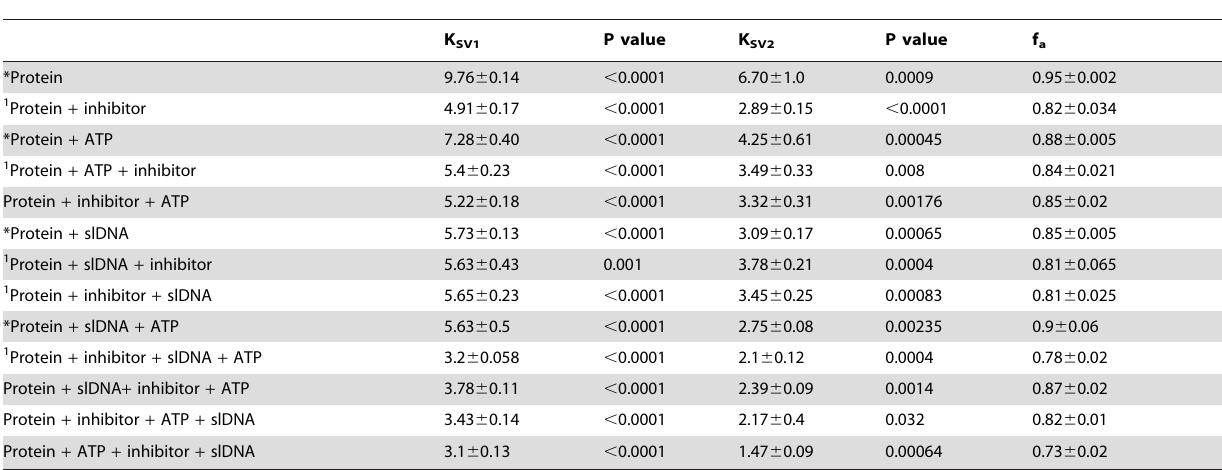
Table 3. Calculation of K SV1 and K SV2 for Protein-ATP-DNA-inhibitor